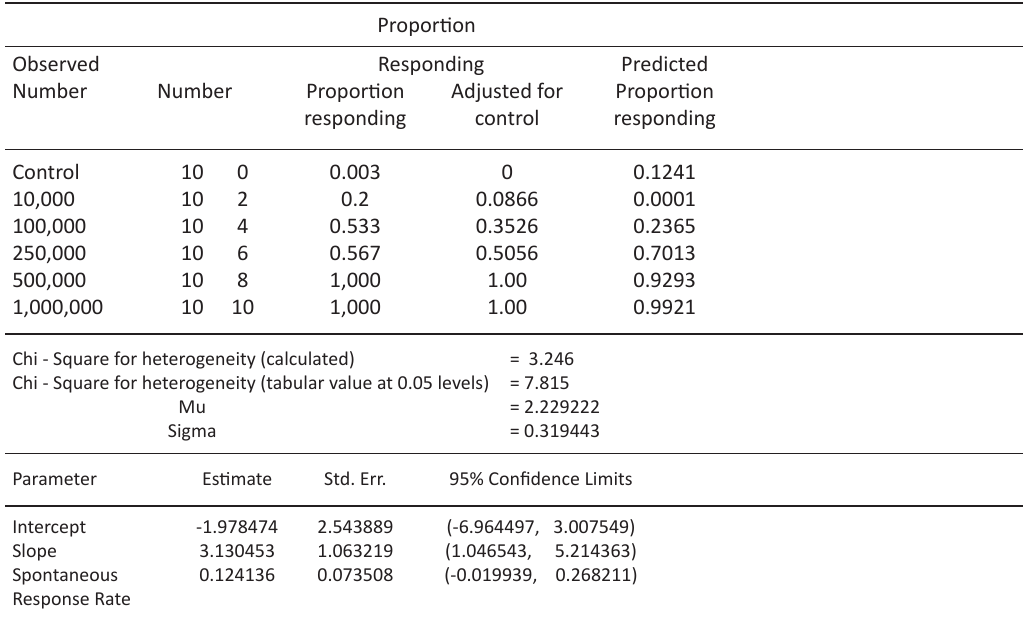
Table 2. Probit Test Toxicity Test Extract of Bacillus sp . against Artemia salina Leach